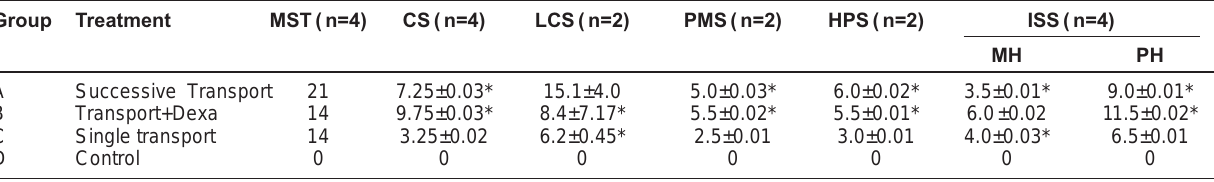
Table-2. The average mean survival time, clinical, lung consolidation, post mortem, histopathology and immunostaining scores for goats with different treatment groups. Group